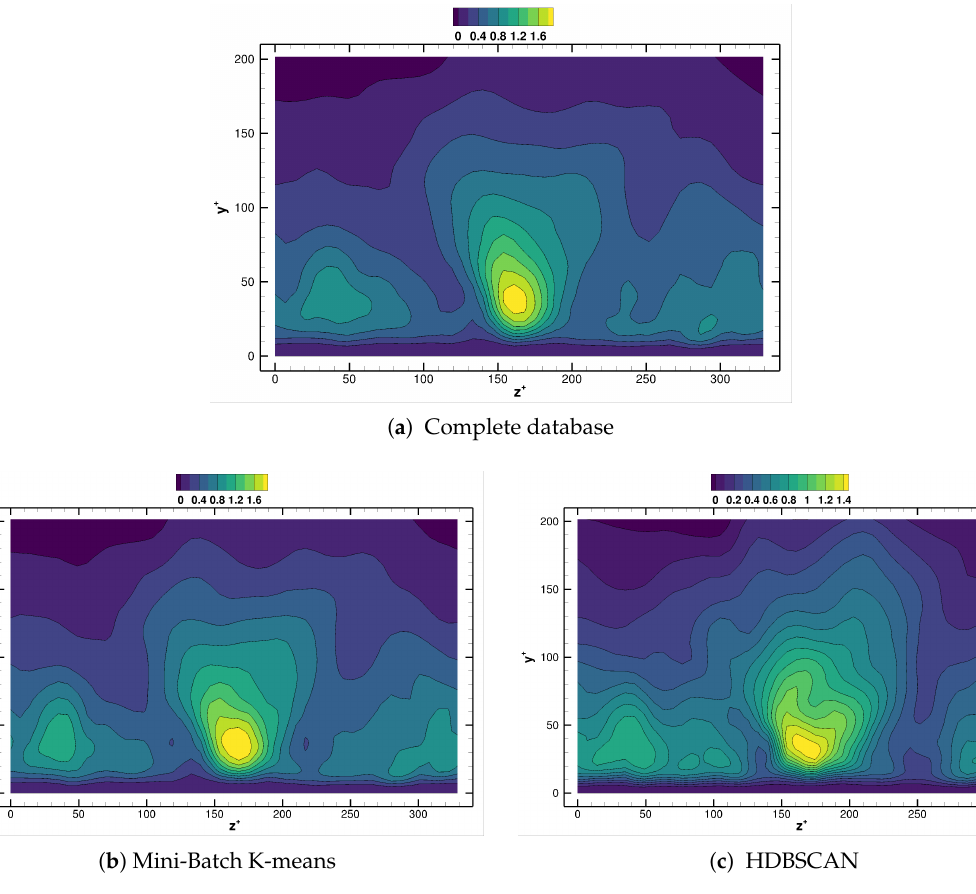
Figure 14. Re τ = 200 turbulent channel flow: distribution of centroids along y + for different agglomeration strategies.